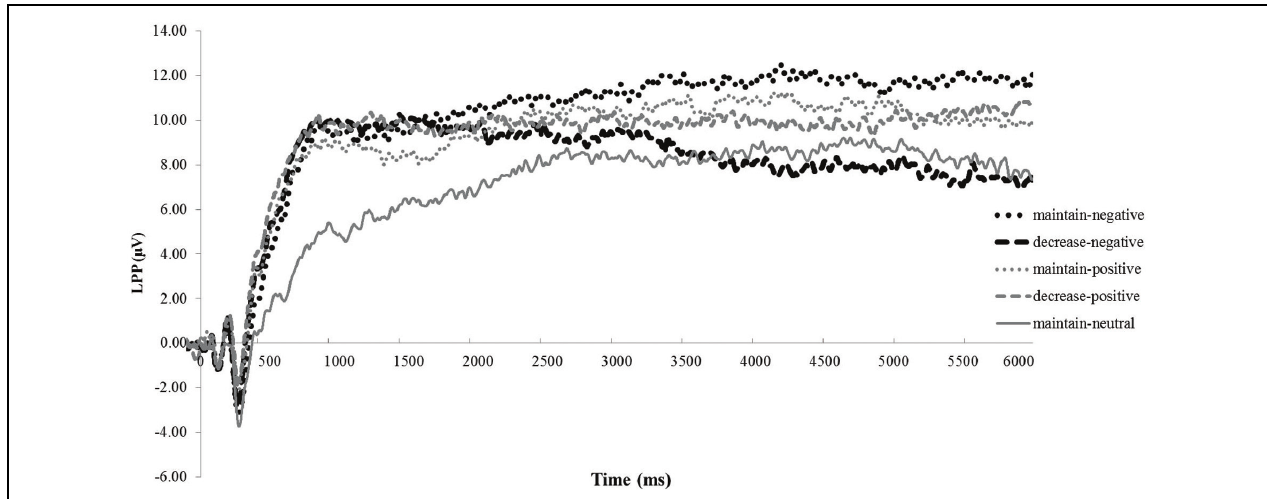
FIGURE 3 | The time course of late positive potential (LPP) activity. Depicted are LPP activities in each experimental condition collapsed across groups: maintain-neutral (black dotted line), maintain-negative (black solid line), decrease-negative (gray solid line), maintain-positive (black slashed line), and decrease-positive (gray slashed